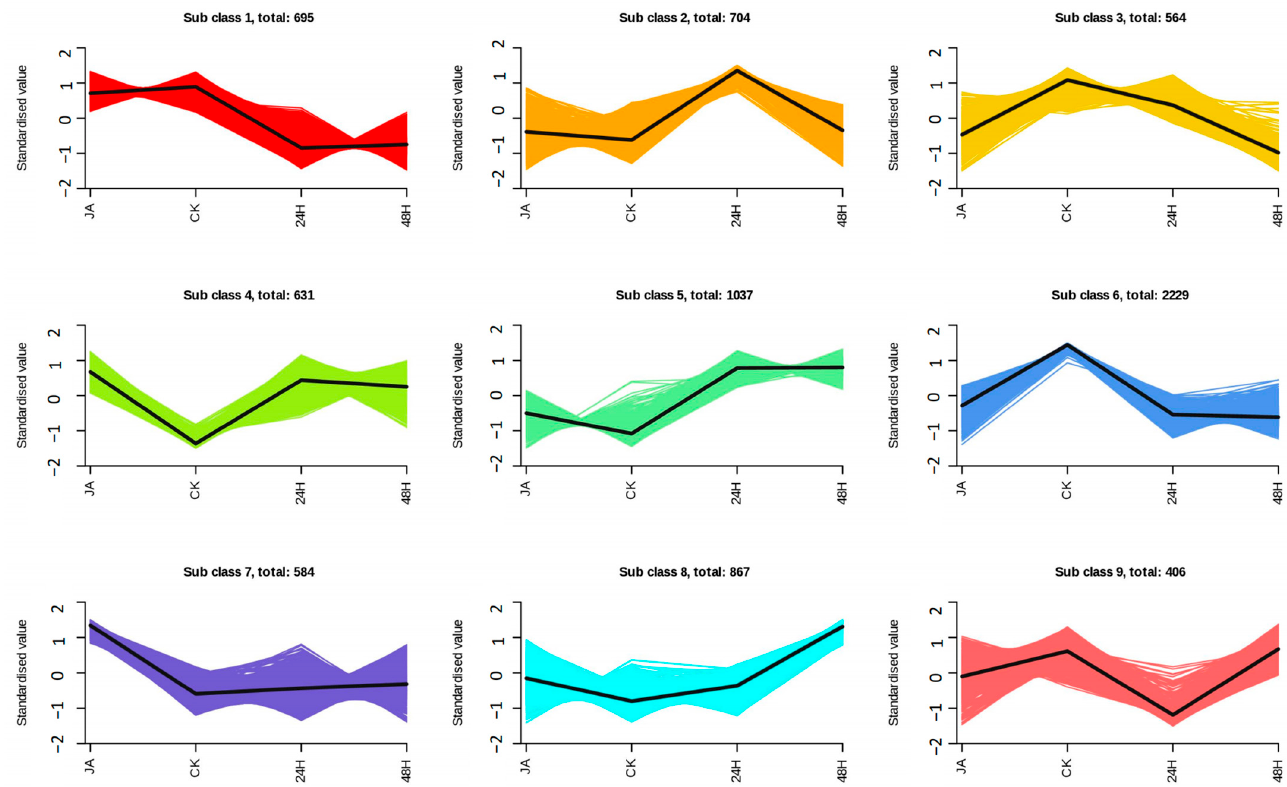
Figure 5. K-MEAN analysis of transcripts in different samples; the y -axis is the standardized value, which represents the expression level of each cluster in different groups.